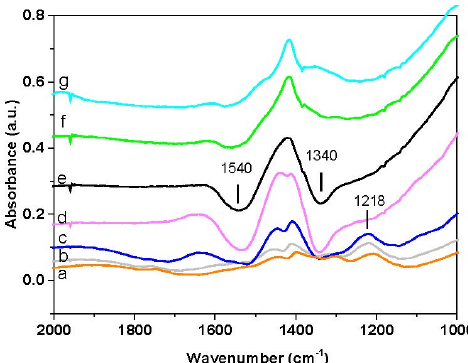
Figure 4. FT ‐ IR spectra obtained during NO/H 2 –TPR with NO (1000 ppm) + H 2 (2000 ppm) over Pt ‐ BaO/Al 2 O 3 from 40–400 °C (4 °C/min) at: ( a ) 40 °C; ( b ) 77 °C; ( c ) 85 °C; ( d ) 152 °C; ( e ) 252 °C; ( f ) 354 °C; ( g ) 400 °C (rig#3).